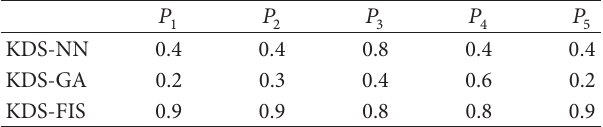
Table 3: Performance matrix ( 𝑅 ) based on definite instances over sensor